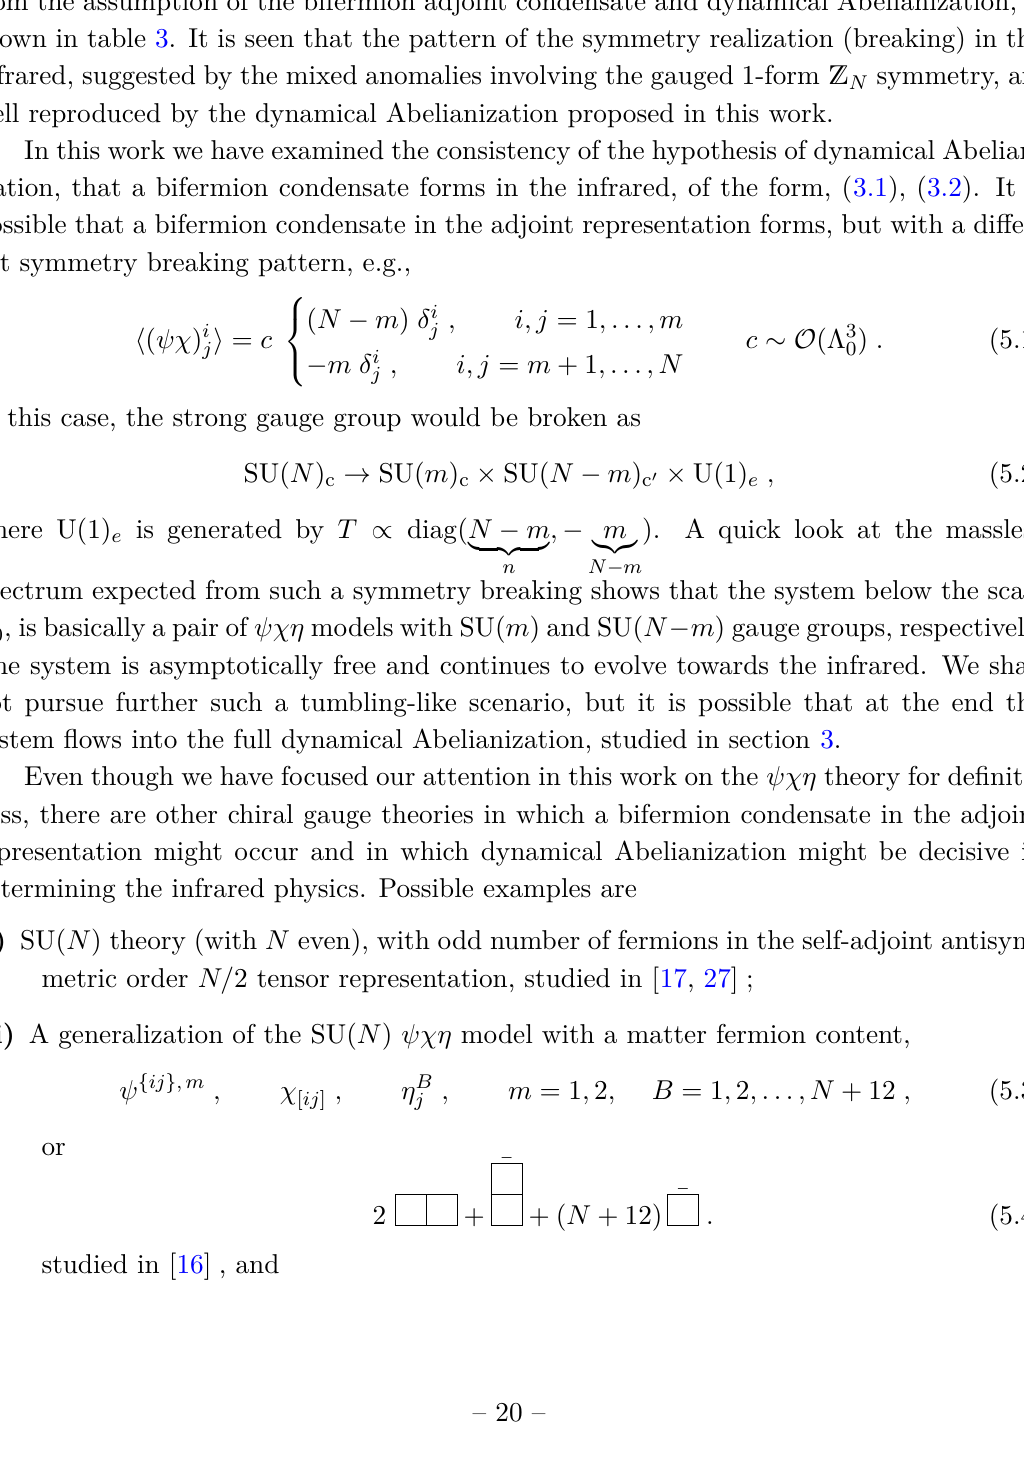
is defined in 4 /N ∗